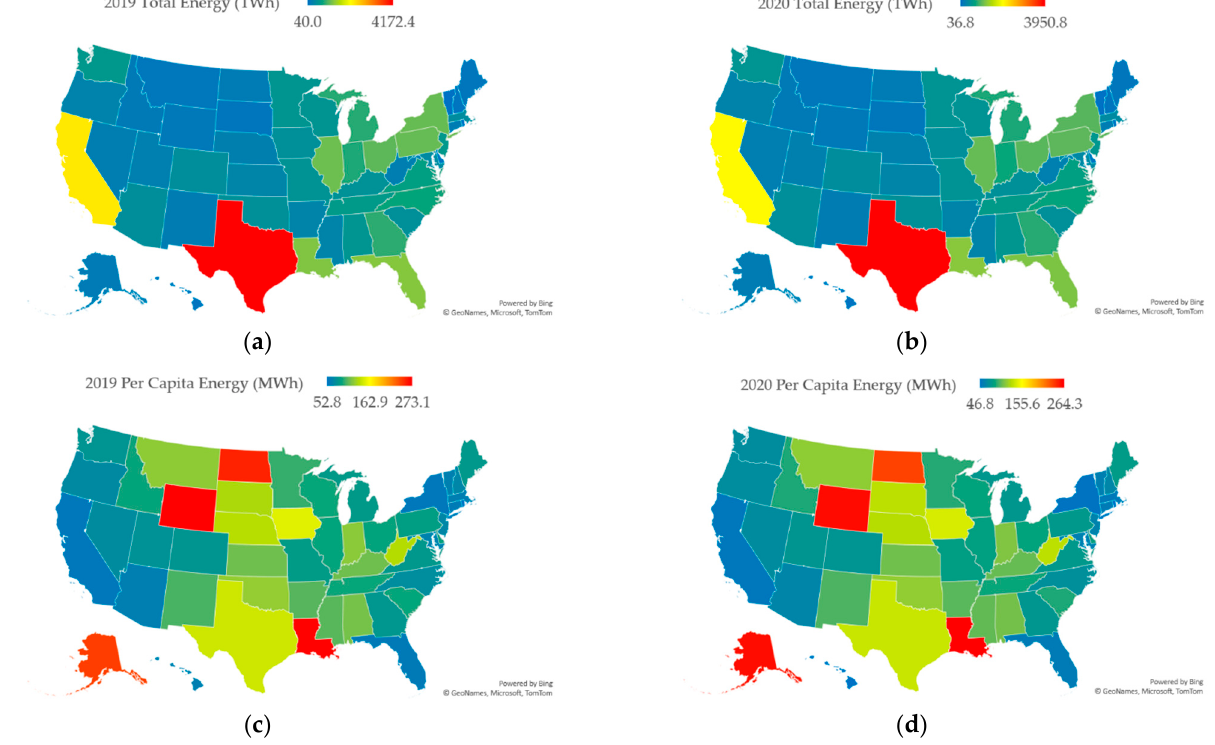
Figure 5. US state-wise energy consumption: ( a ) 2019 total energy; ( b ) 2020 total energy; ( c ) 2019 per capita energy; ( d ) 2020 per capita energy [30].